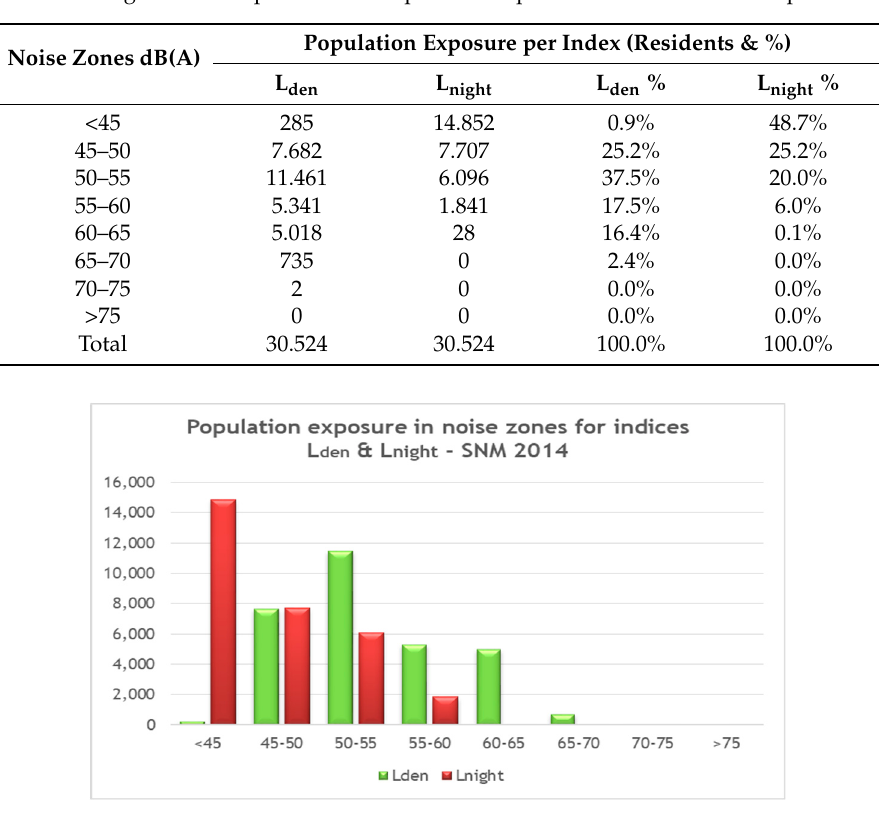
Table 2. Strategic Noise Map of Corfu—Population exposure in noise zones of airport noise.